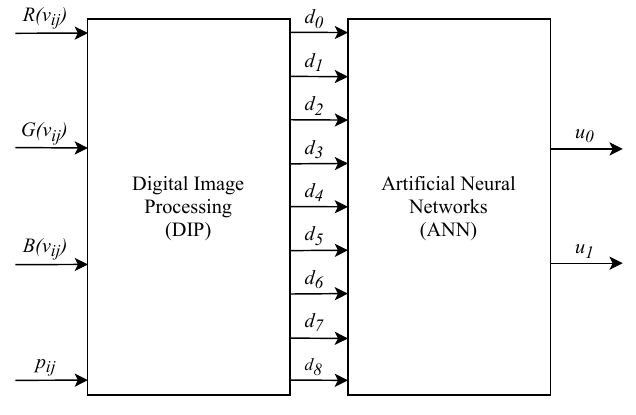
Figure 8. General hardware